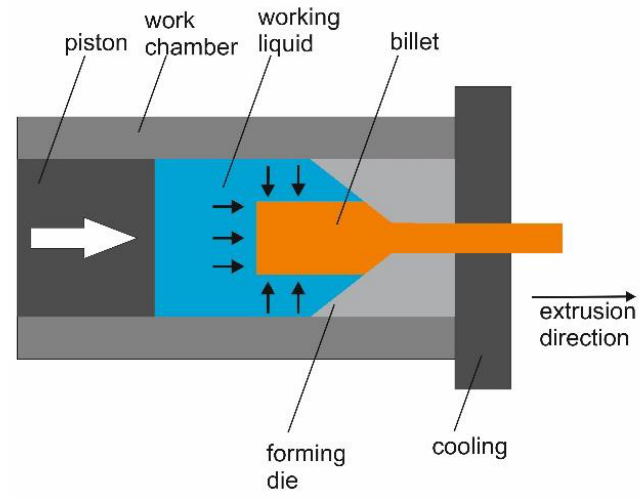
Figure 1. Scheme of the hydrostatic extrusion process.